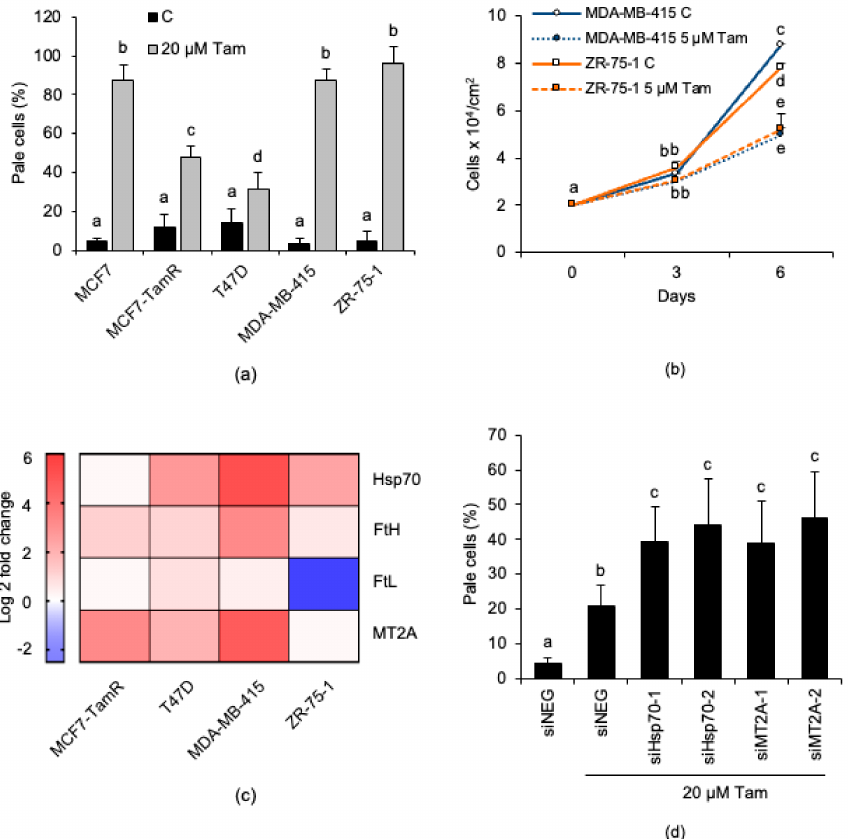
Figure 8. Abundance of iron-binding proteins and capability to activate autophagy concur to shape the susceptibility to Tam-induced LMP of breast cancer cell lines of the luminal A subtype. ( a ) Susceptibility to Tam-induced LMP of breast cancer cells treated with 20 µ M Tam for 2 h and subsequently stained with LysoTracker Red for LMP quantification. ( b ) Growth characteristics of MDA-MB-415 and ZR-75-1 cells in the absence or presence of 5 µ M Tam. ( c ) Heat map representing the Log2 fold change of the iron-binding protein mRNAs in different breast cancer cell lines; the relative mRNA content was normalized to that of MCF7 cells, which was set to 1; blue or red colors indicate genes that are down- or upregulated, respectively. ( d ) Effect of siRNA-mediated knockdown of Hsp70 and MT2A on susceptibility to Tam-induced LMP in T47D cells. For panels ( a , b , d ) data and statistical analysis are as in Figure